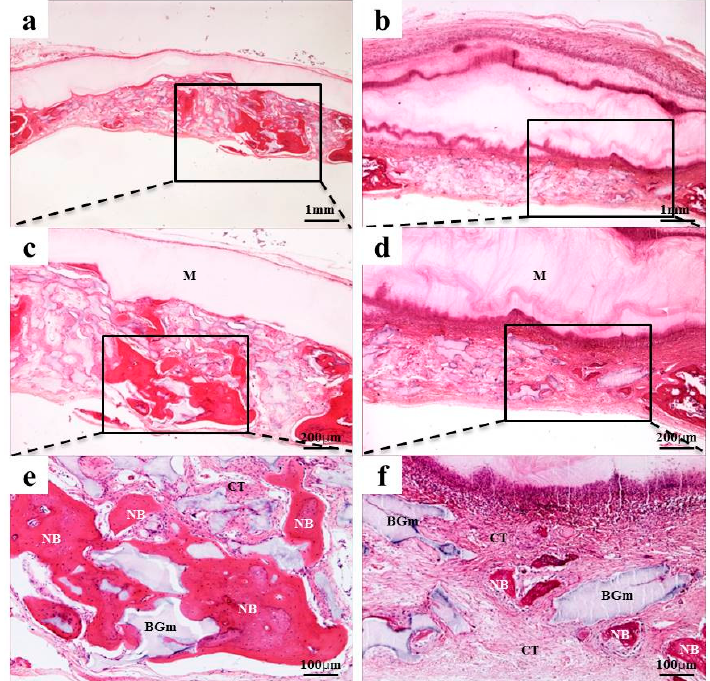
Figure 6. BC membranes: 0.15 mm and 0.20 mm. Histological sections of defect sites at 8 weeks after surgery: ( a , c , e ) 0.15 mm BC; ( b , d , f ) 0.20 mm BC. NB, Fibrous connective tissue ; M, membrane; CT , connective tissue ; BGm , bone grafting material. Original magnification: ×20 (a,b), ×40 (c,d), ×100 (e,f).